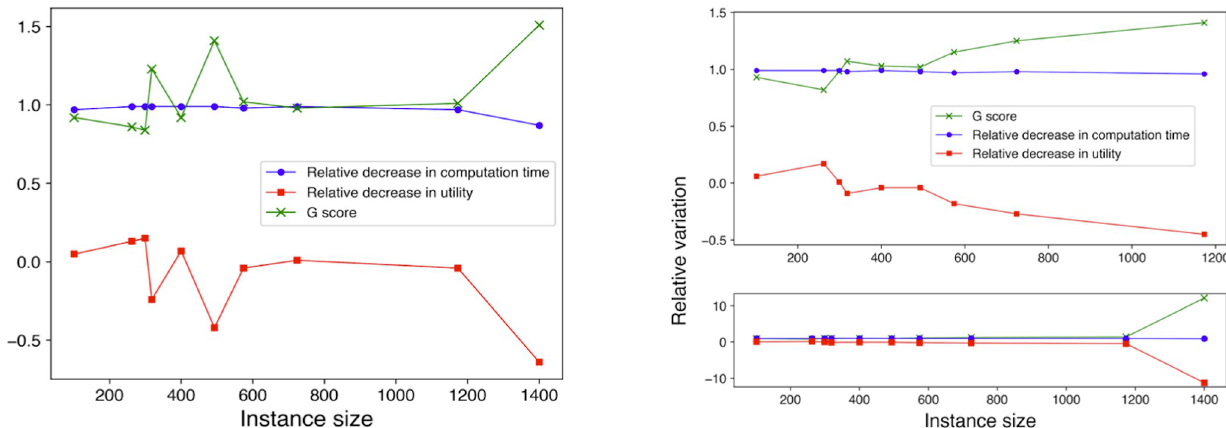
Fig 5. Performance of MH vs. H . Gain achieved by using MH instead of H vs. instance sizes. (Left) OP instances with Flat utility scores. (Right) OP G G G G instances with Random utility scores. In the upper plot, gains do not include the largest test instance, pr2392, since in this case the relative improvement using MH is two orders of magnitude such that data points for the other instances get flattened out. The lower plot is the same as the upper one but G including the data for